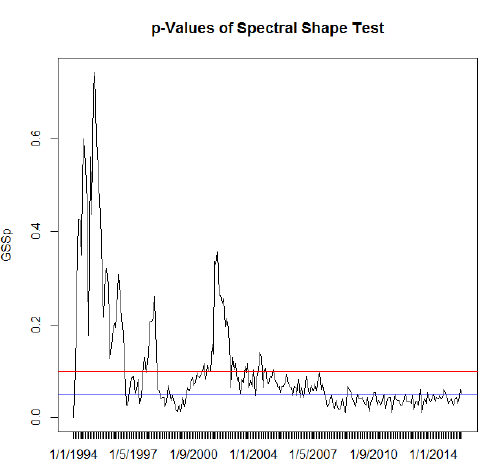
Note: The two horizontal lines correspond to 5% and 10% Note: the two horizontal lines correspond to 0.05 and 0.1 Figure 5. Results of the DL test of Dominguez and Figure 4. Results of the Spectral Shape GSS test of Escanciano and Velasco (2006)